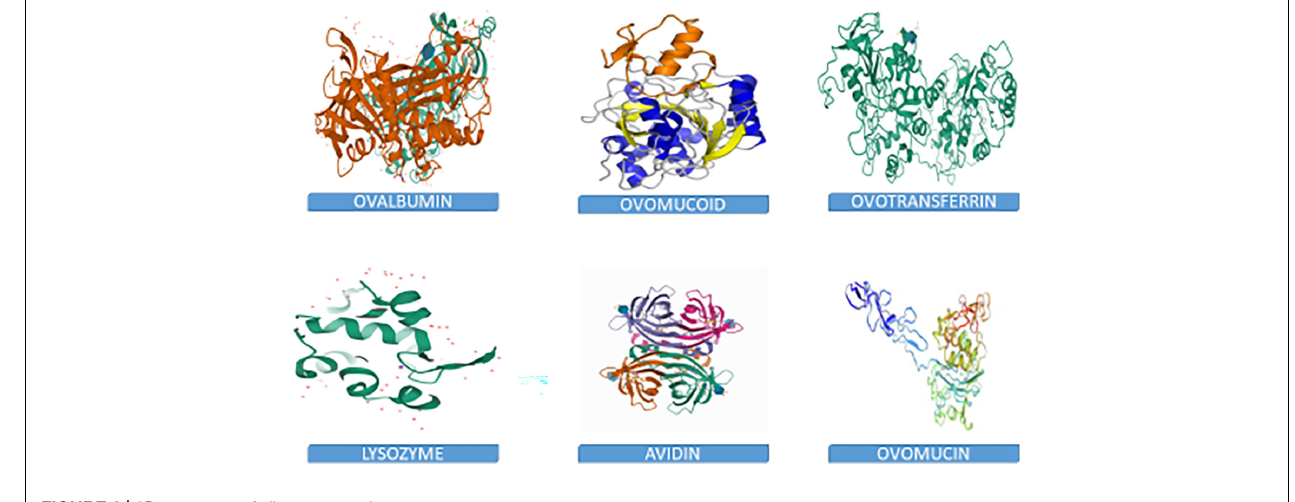
FIGURE 2 | 3D structures of albumen proteins.